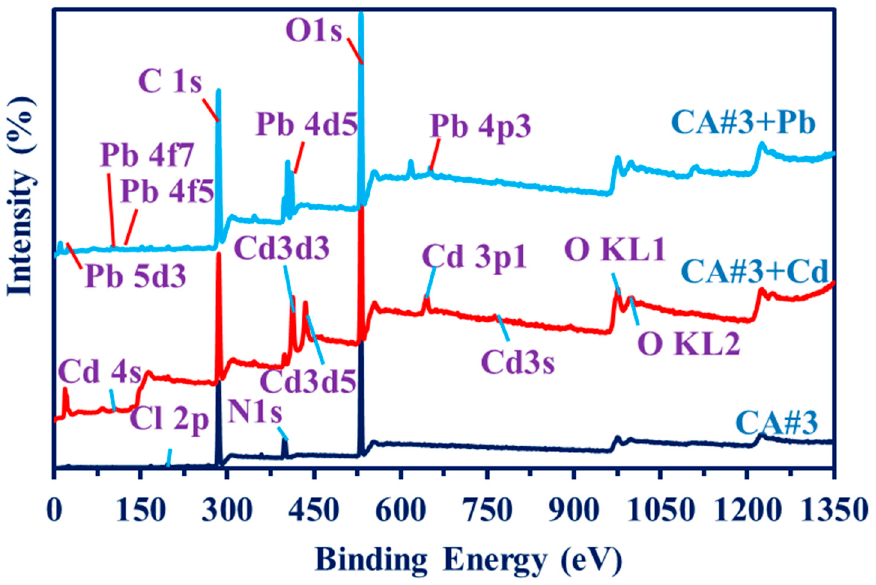
Figure 2. Overall XPS analysis for CA#3, after loading with Cd(II) and Pb(II) metal